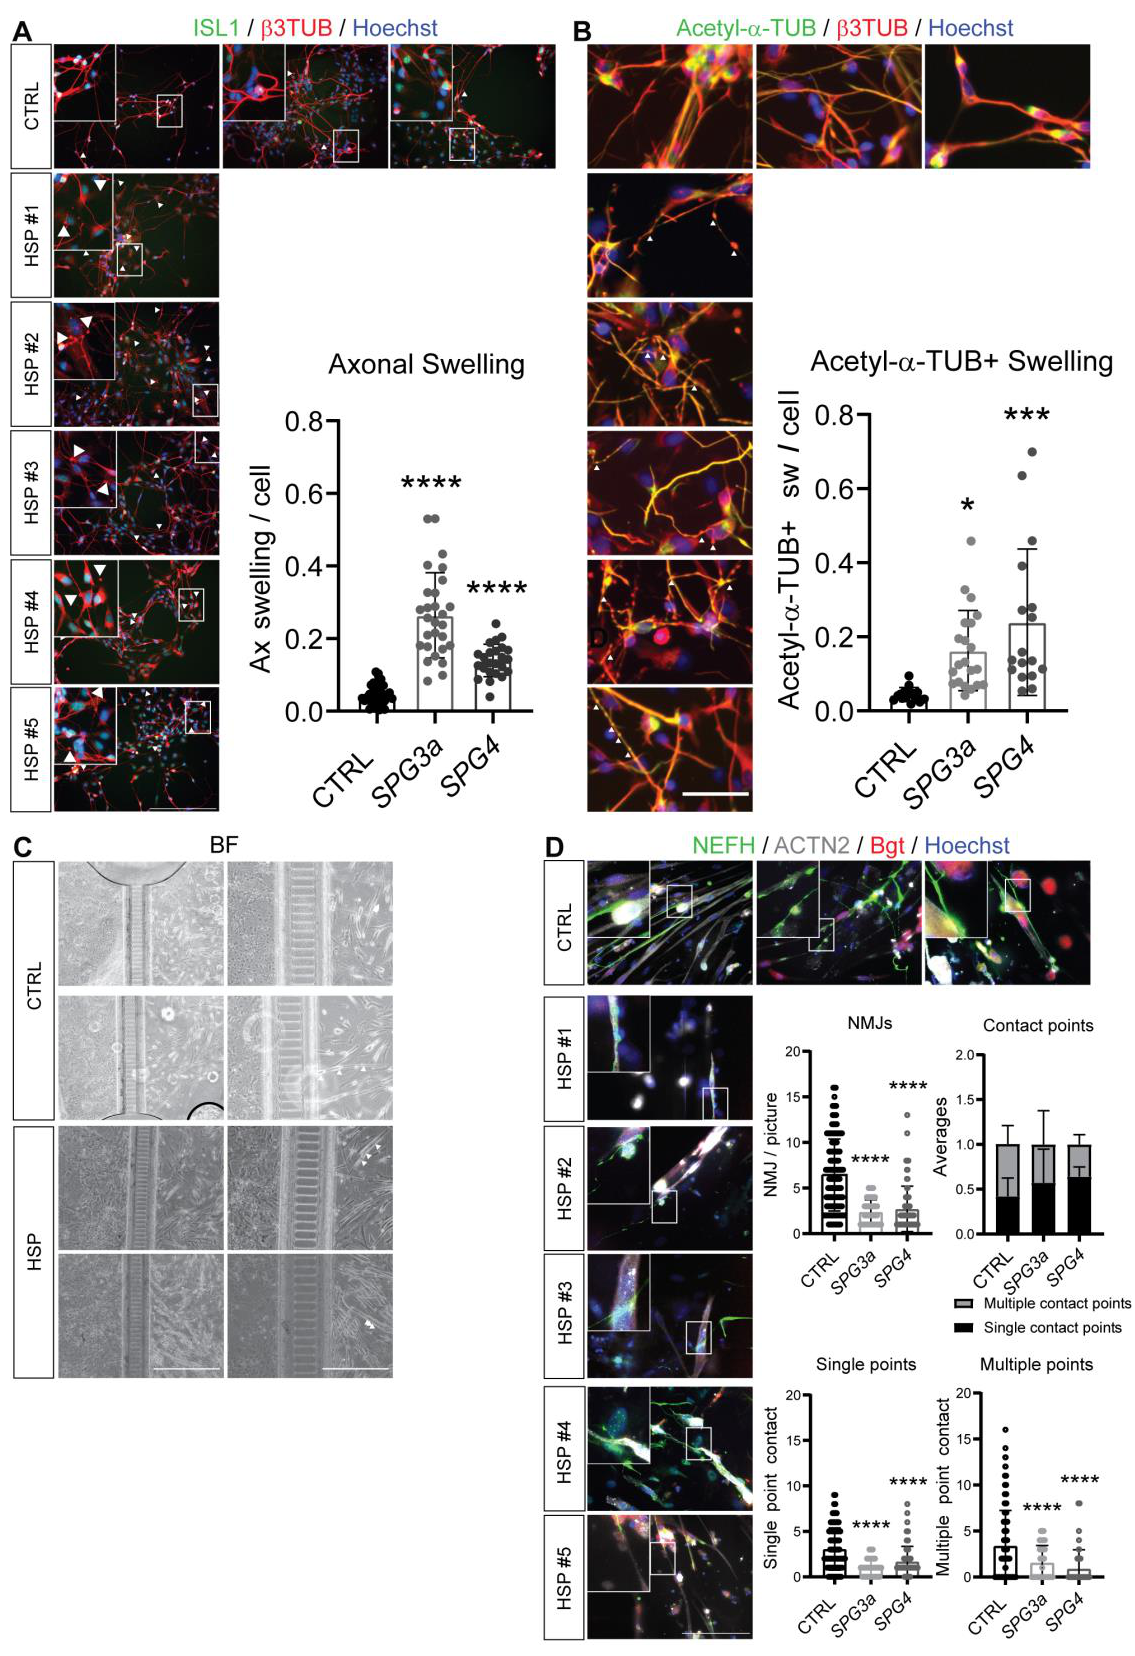
Figure 5. Phenotypical features of lower MNs from HSP patient-derived hiPSCs. Immunostaining (boxed region magnified in the upper-left inset) and quantifications of ( A ) β 3TUB-positive swellings from β 3TUB (red) and ISL1-positive (green) lower MNs or ( B ) Acetyl- α -TUB-positive